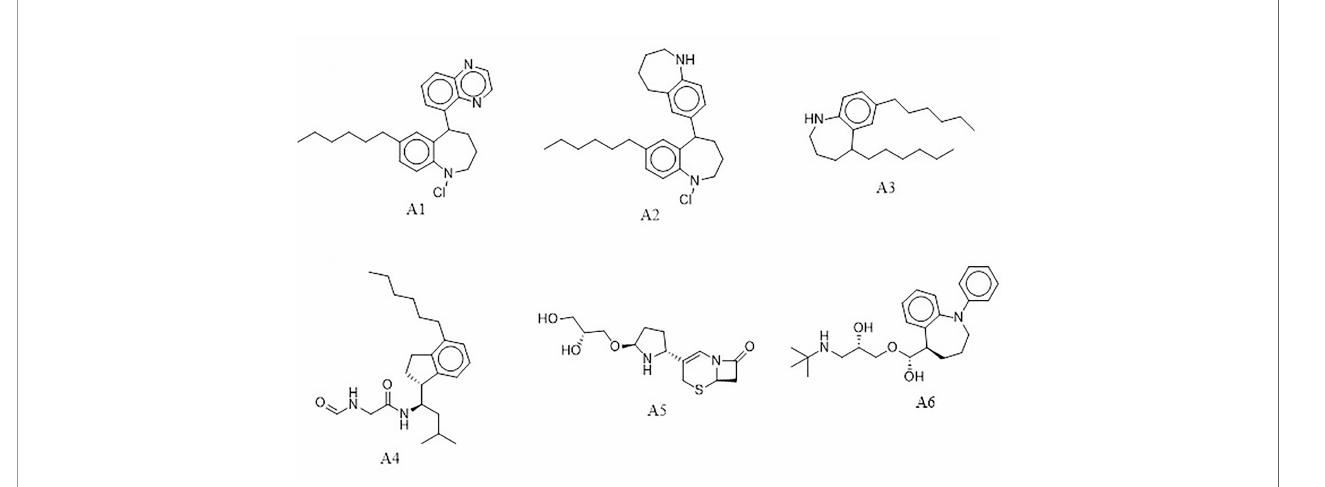
FIGURE 4 | Top hits from de-novo drug design using the